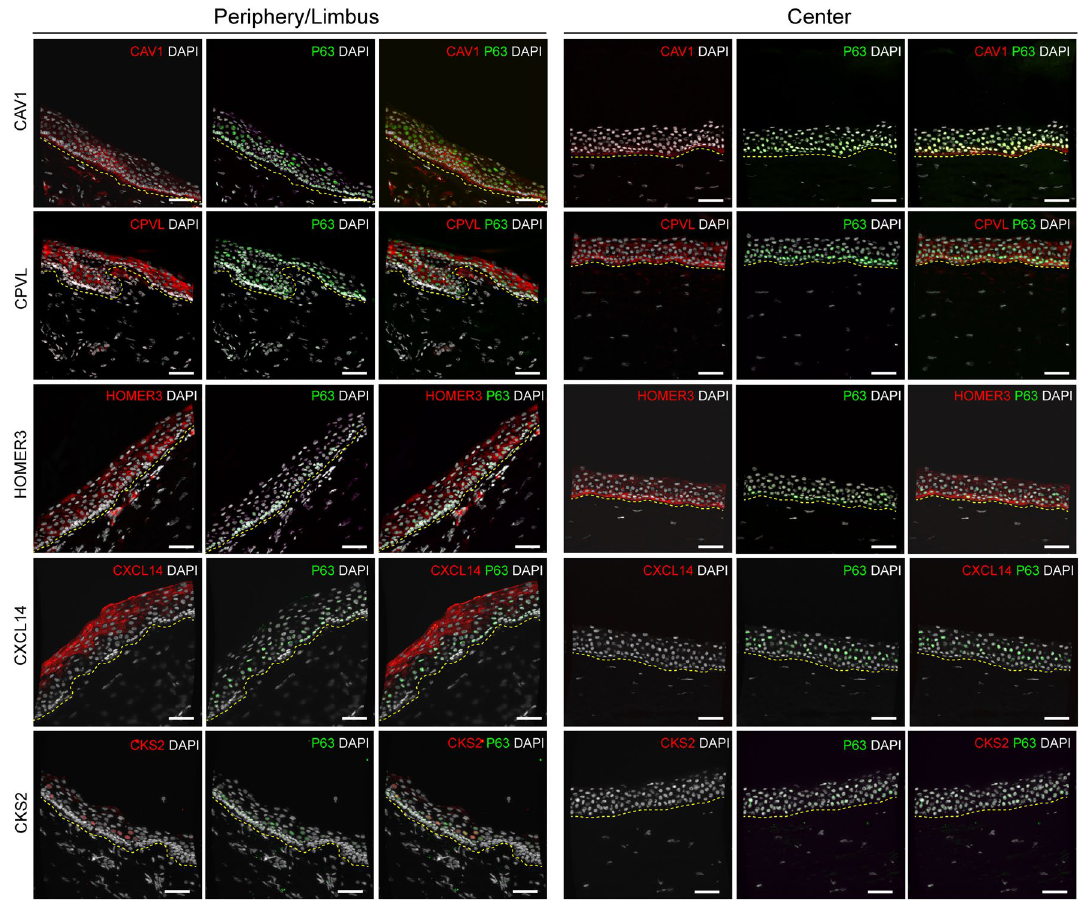
Figure 4. Immunofluorescence of caveolin-1 ( CAV1 ), CXCL14 and CKS2 (red) on human corneal tissue cryosections confirmed differential protein expression in the limbus/periphery, and absence (CKS2, and CXCL14) or minimal expression (caveolin-1) in the central cornea. Basal corneal epithelial cells retained minimal expression of both ΔNp63 and caveolin-1, suggesting their limbal origin. HOMER3 and CPVL were expressed in the limbus, but also in the central cornea, where central basal epithelial cells appeared to have higher expression. P63 (ΔNp63 or p63α) was used as a corneal epithelial limbal cell marker (green). Cell nuclei were stained with DAPI (white). The yellow dashed line indicates the boundary between epithelium (above) and stroma (below). Scale bars represent 50